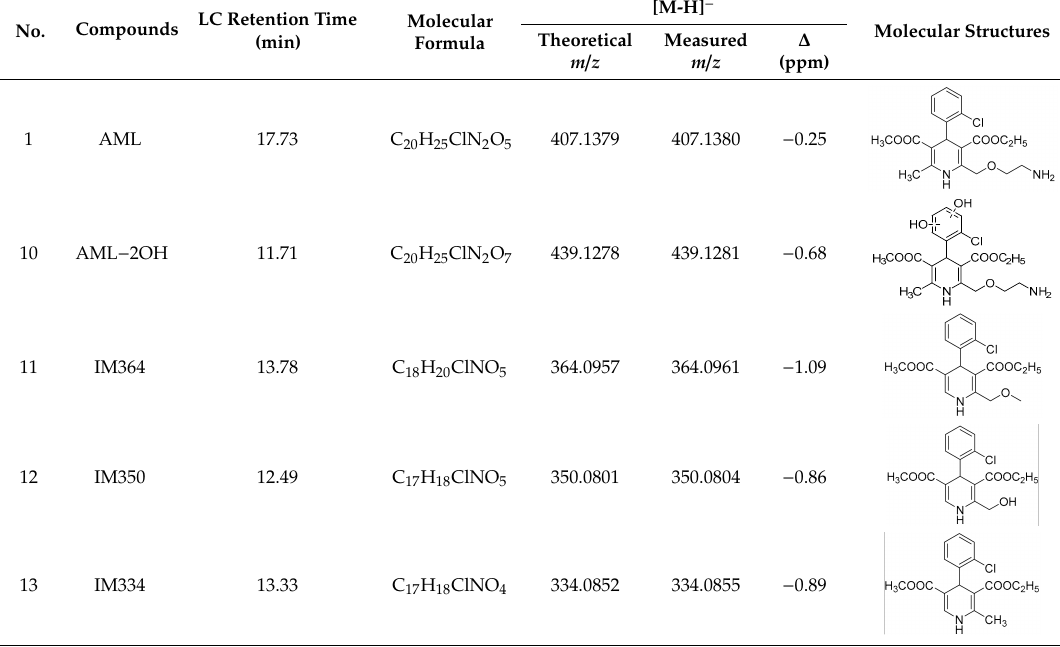
Table 2. Molecular formula, retention time, high-resolution accurate masses ([M-H] − ) with errors ( ∆ ), and molecular structures of AML and its degradation products detected by HRMS.